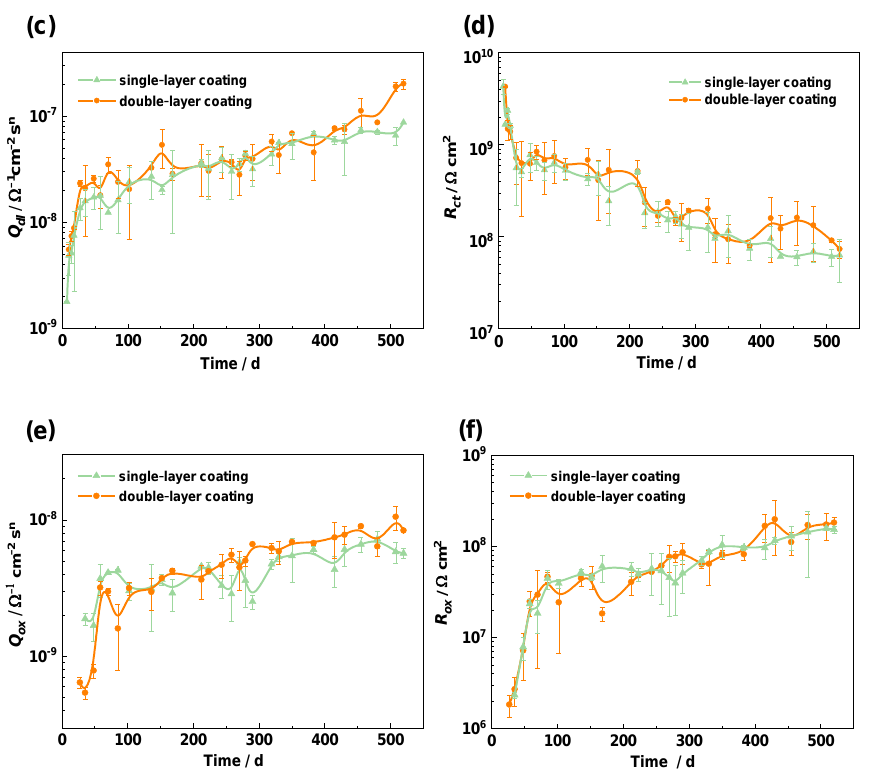
Figure 10. Fitting parameters for two coating samples: ( a ) Q c ; ( b ) R c ; ( c ) Q dl ; ( d ) R ct ; ( e ) Q ox ; ( f ) R ox .